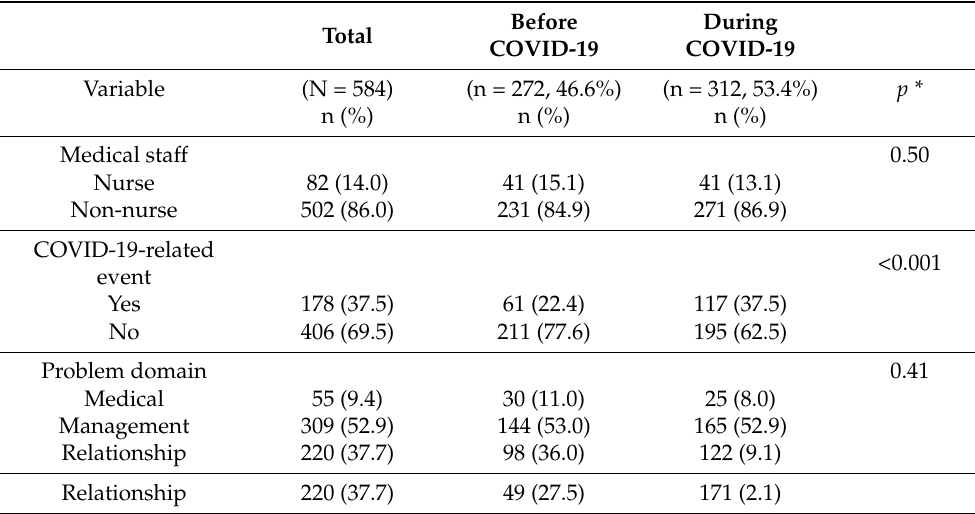
Table 3. Analysis of the healthcare complaints analysis tool domains and problems before and dur- ing the COVID-19 occurrence period.